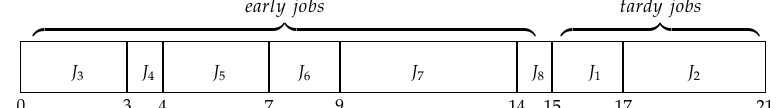
Figure 2. Schedule σ 2 corresponding to Instance I 1 .